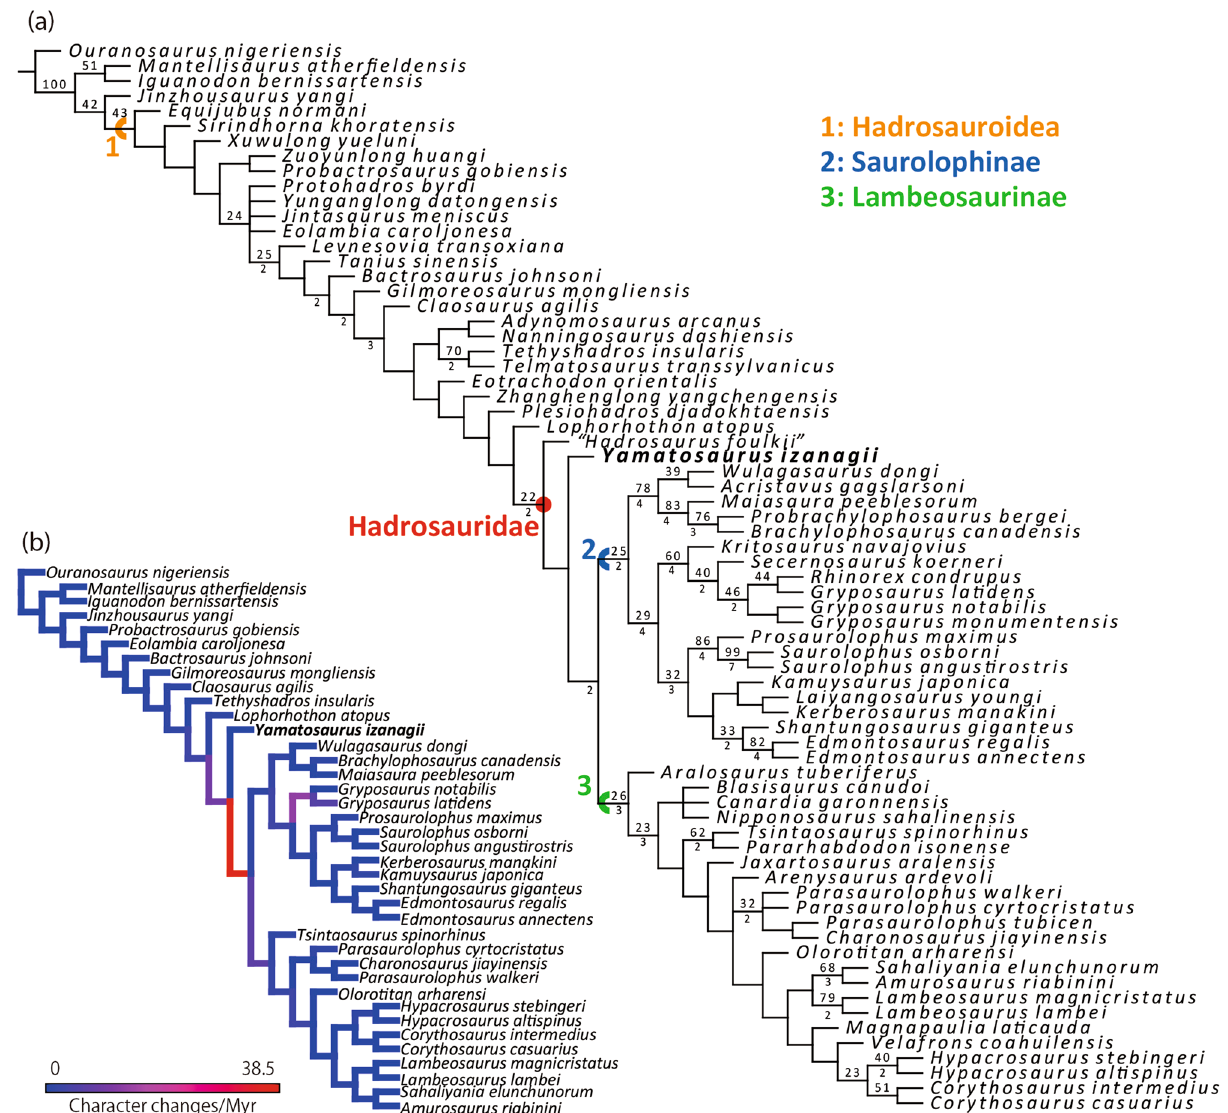
Figure 7. The strict consensus tree of the MPTs obtained from the phylogenetic analysis. The numbers above each branch represent bootstrap values and those below the branch represent the Bremer decay values. The bootstrap values below 20 and the Bremer decay values below 2 are not shown ( a ). Forelimb evolutionary rates on each branch based on the present phylogenetic hypothesis ( b ). Refer Supplementary Fig. S1 for the analysis without Yamatosaurus izanagii